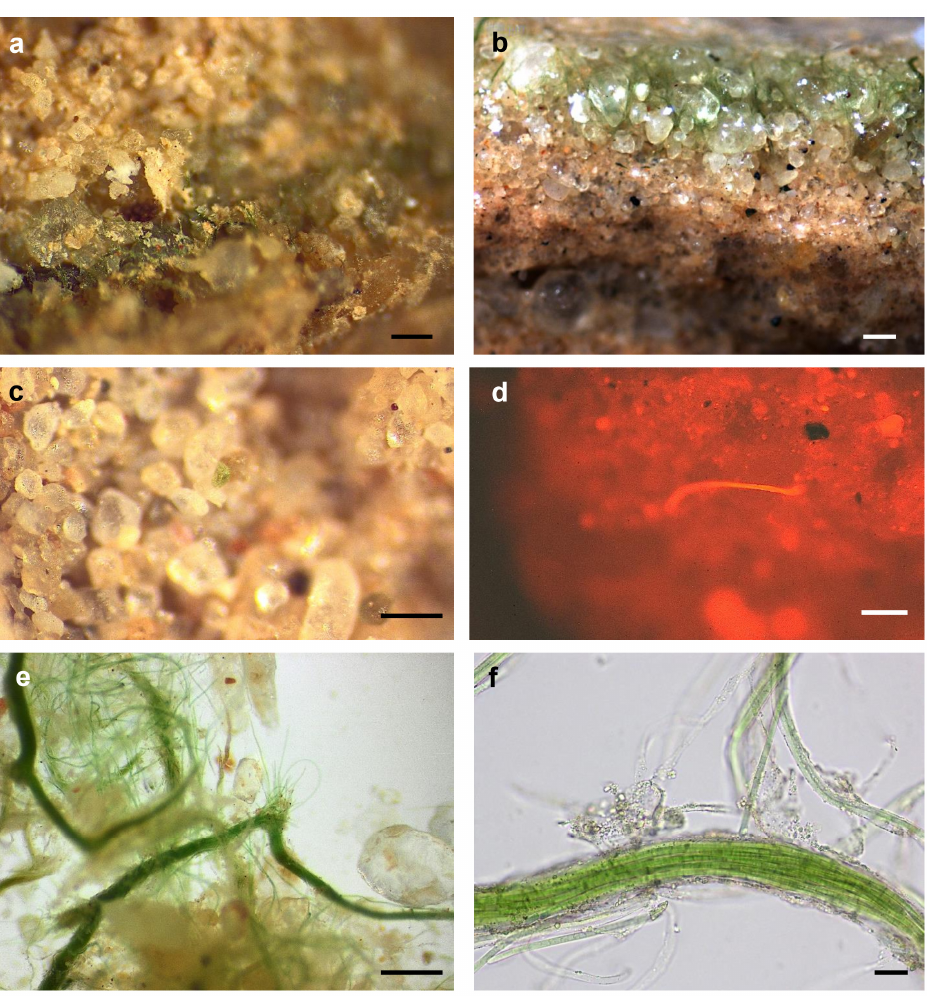
Figure 2. Microphotographs of the biocrusts samples. ( a ) Dry and ( b ) wet biocrust from Taleb Larbi (LSB, Less saline biocrusts)), ( c , d ) Dissecting microscopy of biocrusts from Chott Kralla (SBC, Saline biocrusts), ( c ) bright field microscopy, ( d ) autofluorescence microscopy, ( e , f ) Bundels in biocrusts from Taleb Larbi (LSB). Scale bar 200 µ m, except in ( f ) 20 µ